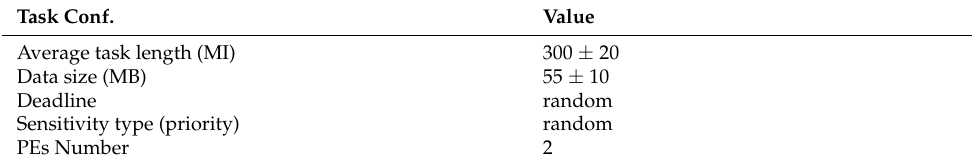
Table 5. Task parameter setting. Task